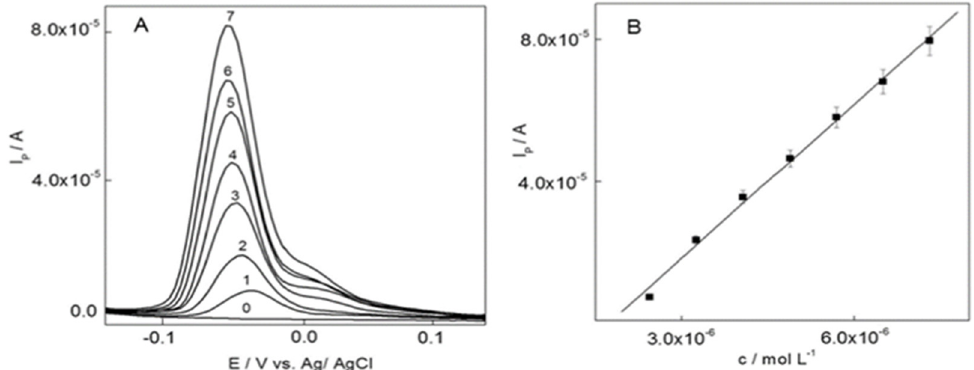
Figure 9. ( A ): Differential pulse anodic stripping voltammograms for 1 µL of 2.034 ×10 − 2 mol L − 1 SbCl 3 additions in 6 mol L − 1 HClO 4 . Concentrations of Sb 3+ : (0) 0, (1) 2.44 × 10 − 6 , (2) 3.25 × 10 − 6 , (3) 4.07 ×10 − 6 , (4) 4.88 × 10 − 6 , (5) 5.69 × 10 − 6 , (6) 6.50 × 10 − 6 , and (7) 7.31 × 10 − 6 mol L − 1 of Sb 3+ on BDD electrode. Parameters: scan rate 25 mV s − 1 , modulation amplitude 40 mV, modulation time 50 s, deposition potential − 1 V vs. Ag /AgCl and deposition time 240 s ( B ): Calibration curve for this experiment. Linearity was verified by F-test (reproduced with the permission of ref [93]).